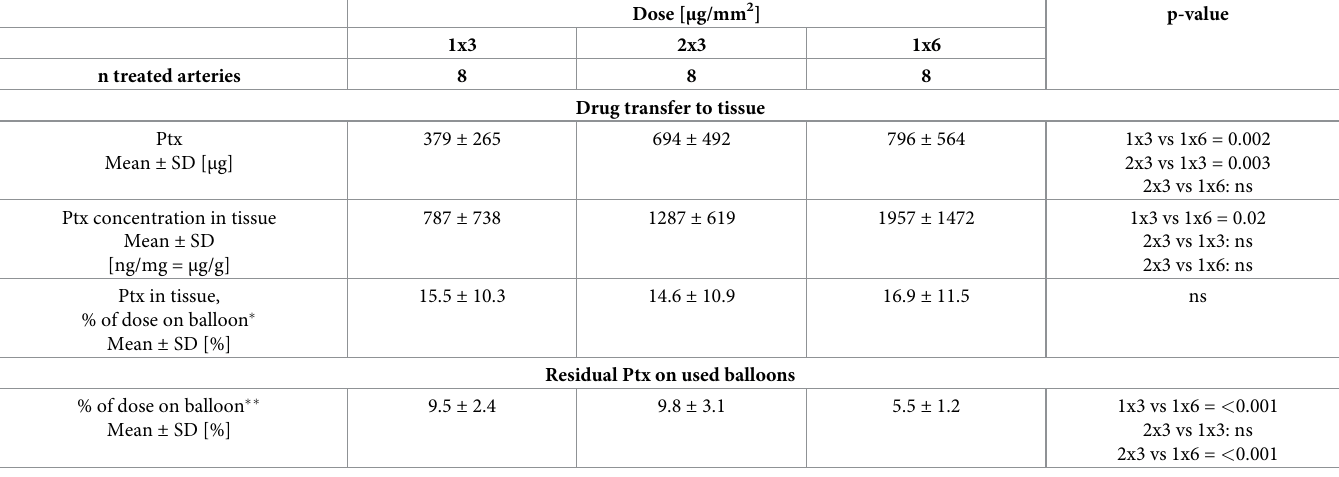
Table 3. Paclitaxel transferred to vessel wall and residual paclitaxel on balloon after treatment–summarized for doses.